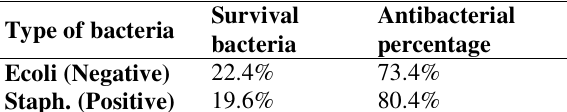
Data of antibacterial